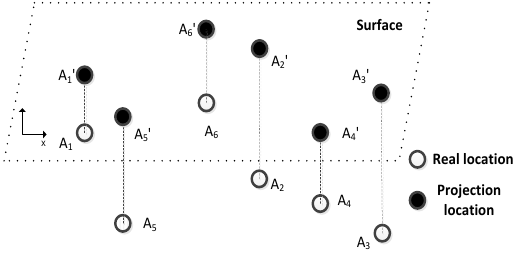
Figure 2. A schematic diagram of the projection method.